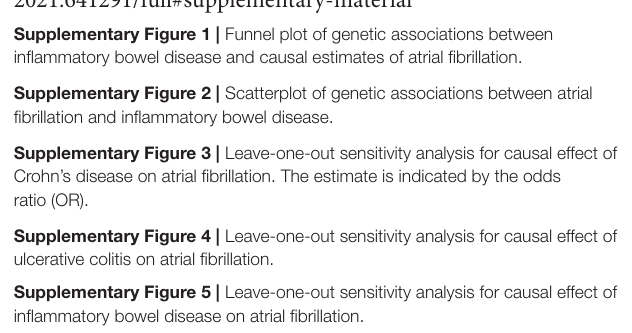
Frontiers in Cardiovascular Medicine |